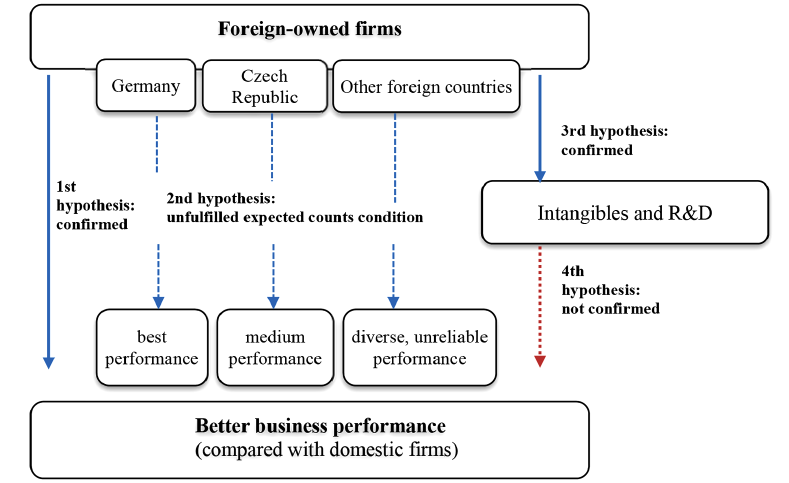
Figure 2. Confirmation of research hypotheses in foreign firms (source: own)